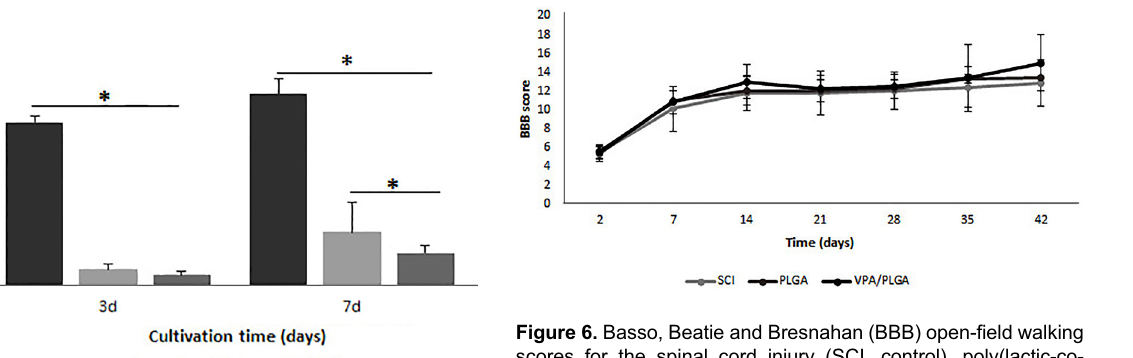
Figure 4. Scanning electron microscopy and fl uorescence microscopy images of PC12 cells cultivated on the poly(lactic-co-glycolic acid) (PLGA) scaffold ( A to D ) and valproic acid (VPA)/PLGA scaffold ( E to H ) after 3 and 7 days in culture (n=2). In red are the actin fi laments stained by rhodamine phalloidin; in blue, cell nuclei stained by DAPI. The cells attached and spread on the biomaterials. Scale bars: 10 m m.